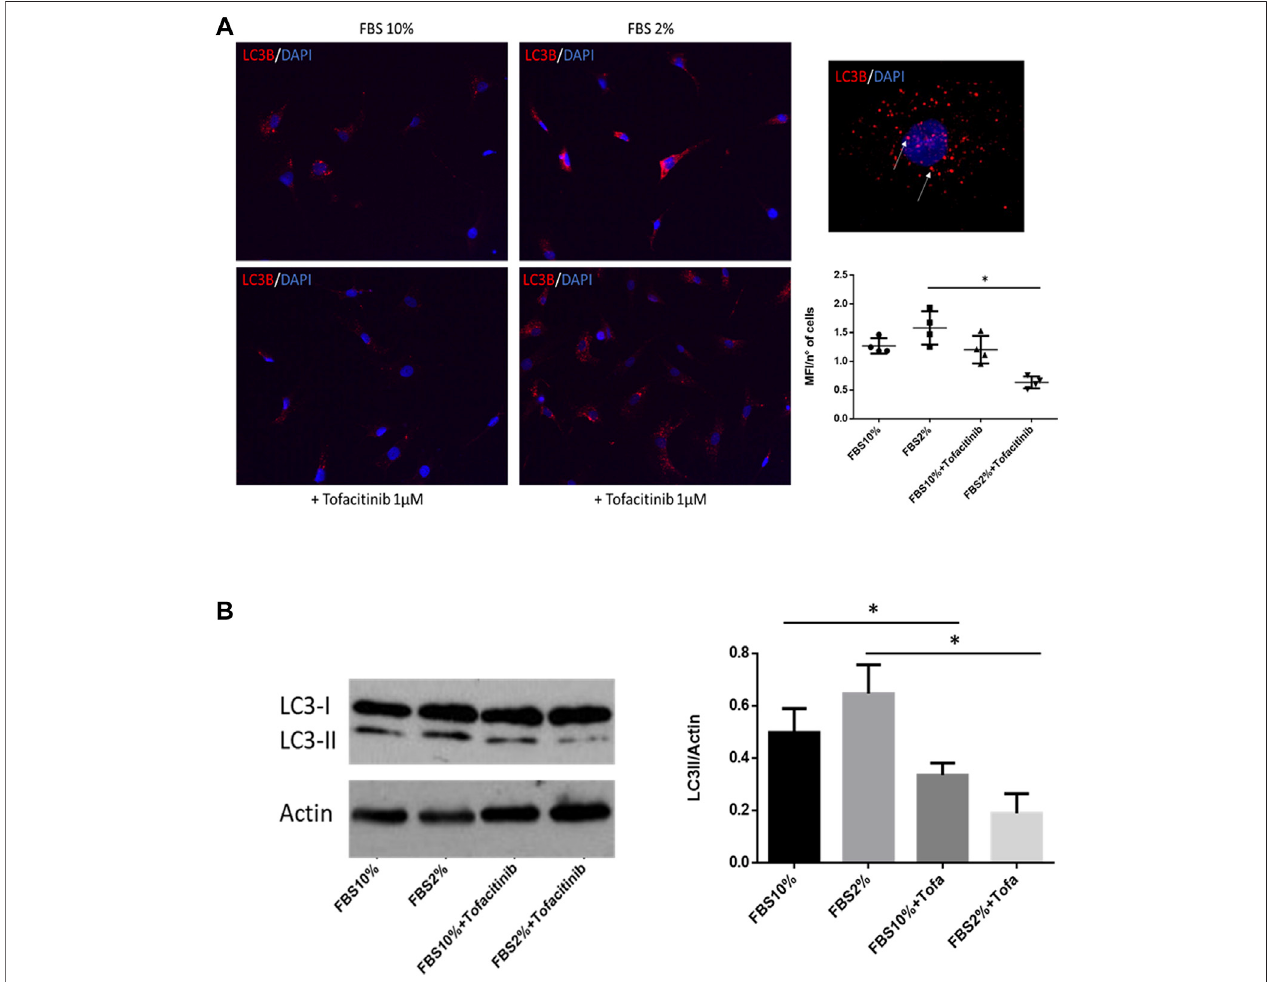
FIGURE2| EffectoftofacitinibonautophagyinFLSculturedinserumdeprivationcondition. (A) Immunocyto fl uorescenceanalysisofautophagyinFLStreatedwith tofacitinib alone and instarvation (FBS 2%). Autophagic LC3B +vesicles arestainedin red in RA FLS treated with tofacitinib alone and in serum deprivation condition